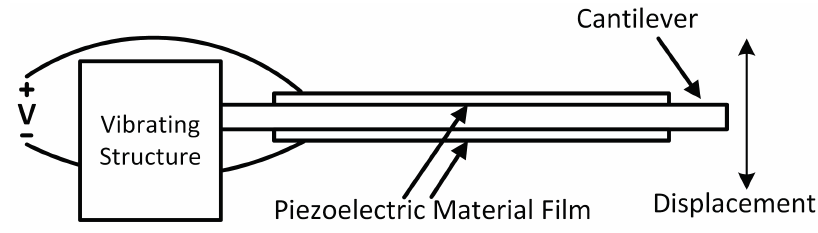
Figure 2. Structure of a piezoelectric device (PD) [36].